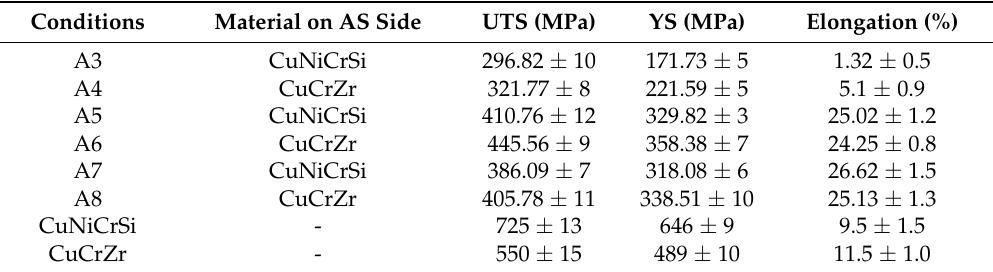
Figure 10. The mechanical properties of dissimilar joints. ( a ) The variation tendency of mechanical properties when the CuCrZr alloy is located on the AS; ( b ) the variation tendency of mechanical properties when the CuNiCrSi alloy is located on the AS; ( c ) tensile strength of joints. (UTS means the ultimate tensile strength; YS means the yield strength). Table 3. The ultimate tensile strength, yield strength, and elongation of different joints.